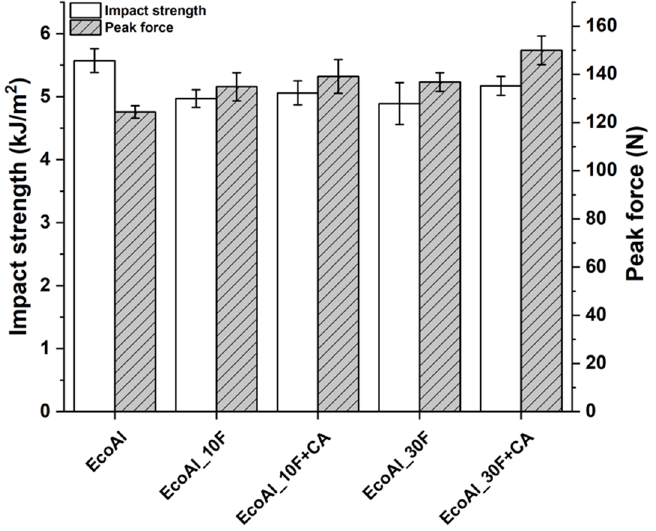
Figure 8. Charpy impact test results of EcoAllene-based composites.